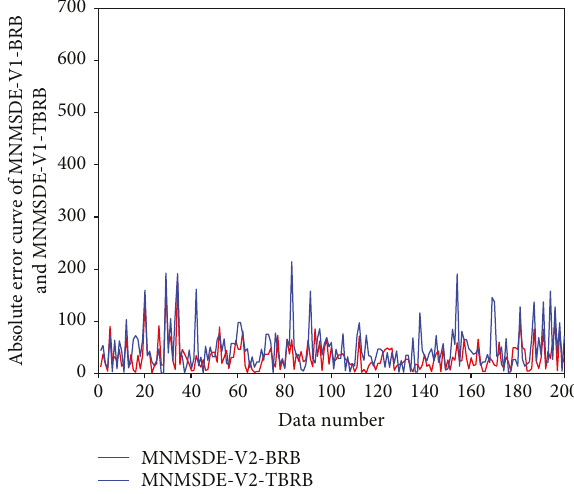
Figure 17: The evolutionary curves of relative error for four compared algorithms. Table 2: Comparison of MaxRE, MinRE, and ARE.